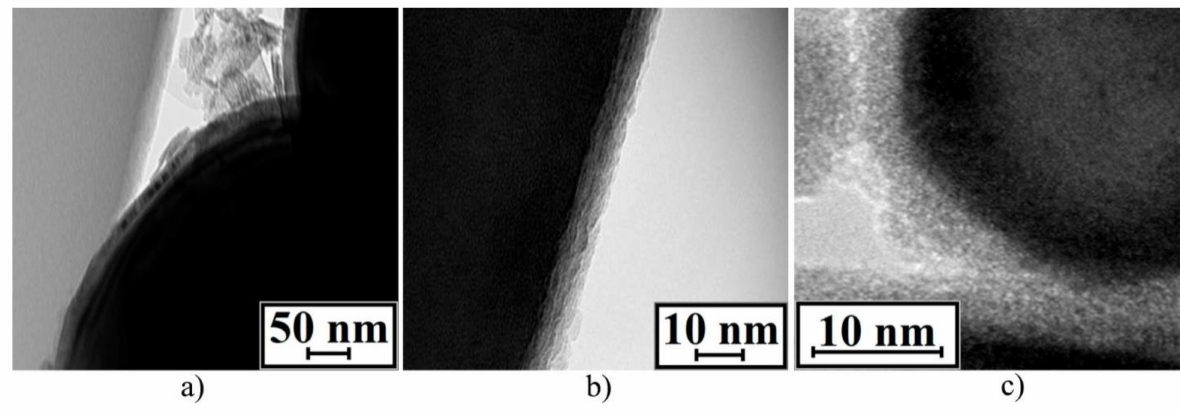
Figure 10. TEM of oxide layers: n–Fe_02 sample ( a ); Fe(n–FeO_01) sample ( b ); Fe(n–FeO_02) sample ( c